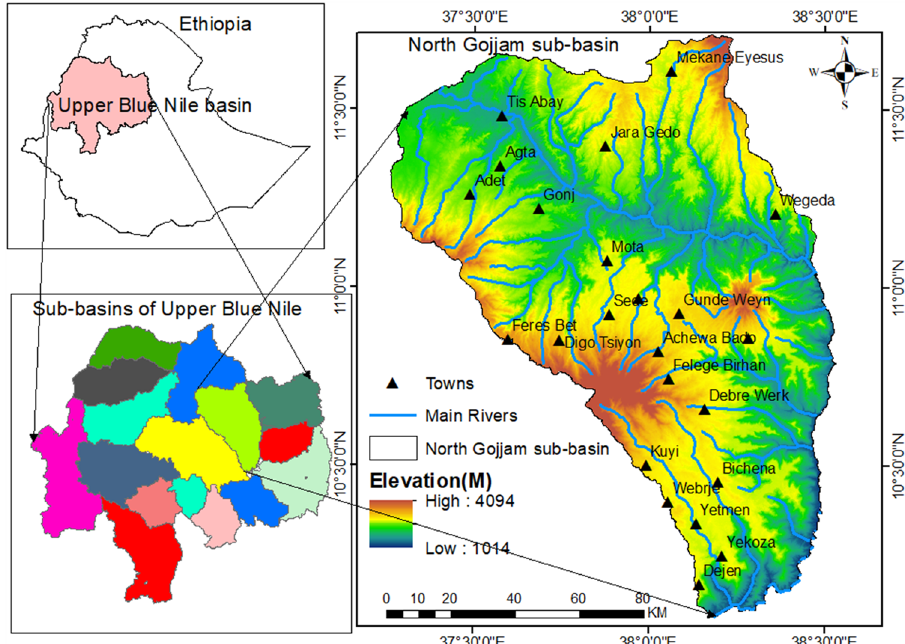
Fig. 1 Topography and loca- tion of the study area [19,